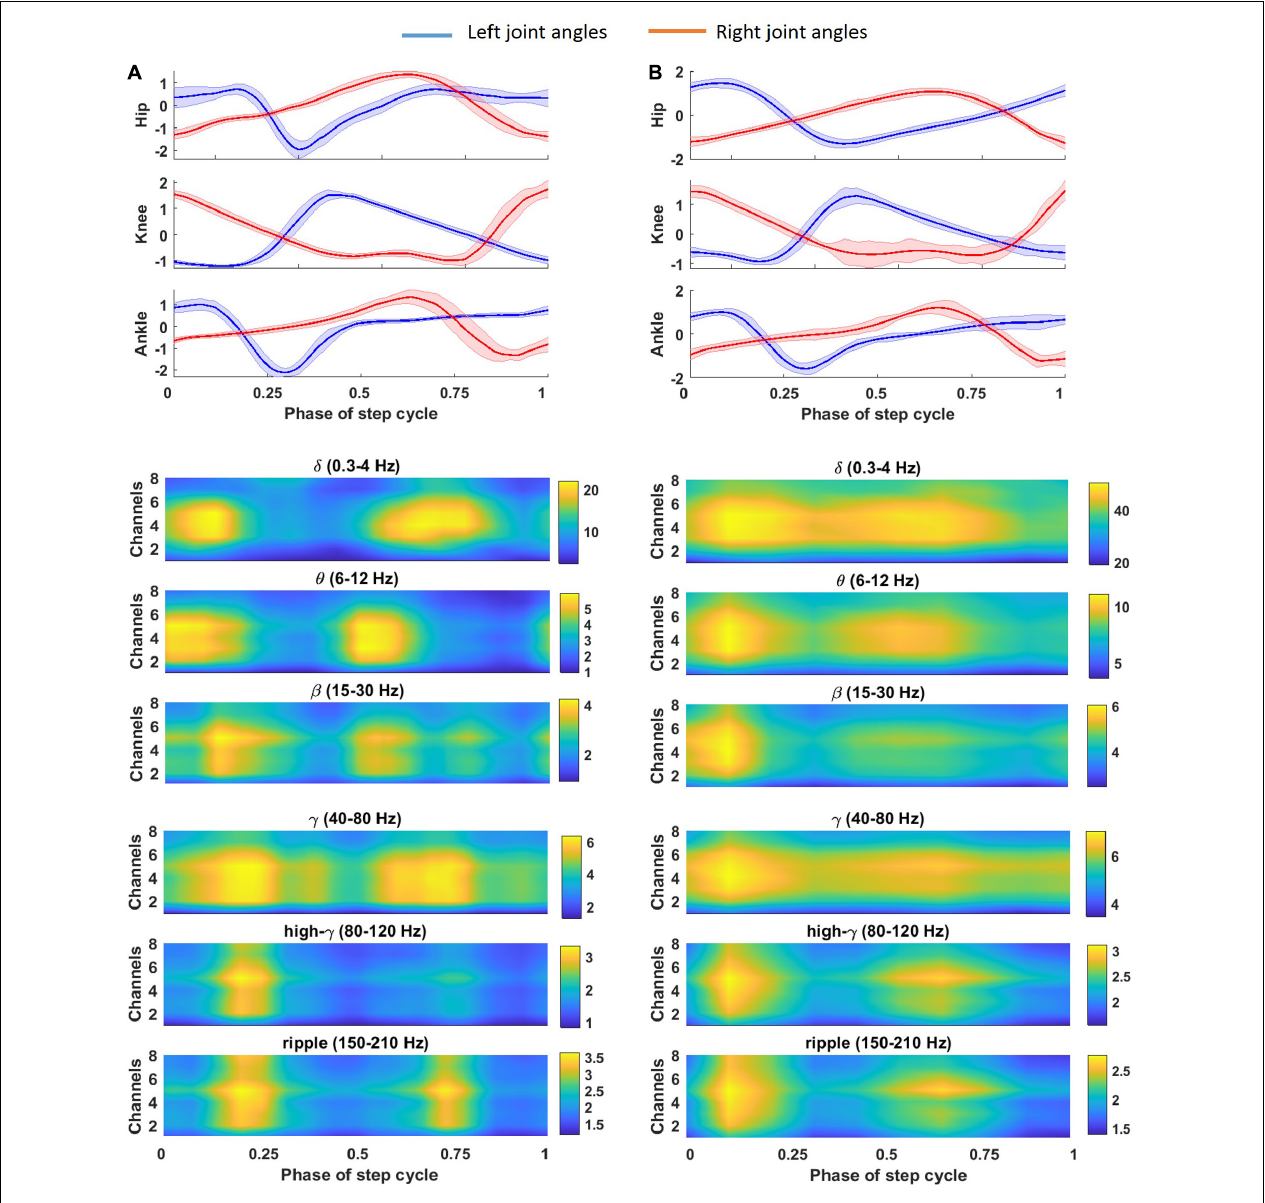
FIGURE 7 | Average of gait cycle for the left (A) and right (B) leg during a typical trial of cat locomotion (cat 1, 56 days post-implant) on the treadmill and corresponding spatial time-frequency analysis of the recorded LFP signal. Average of the LFP envelope over different gait cycles is calculated for each channel and each frequency